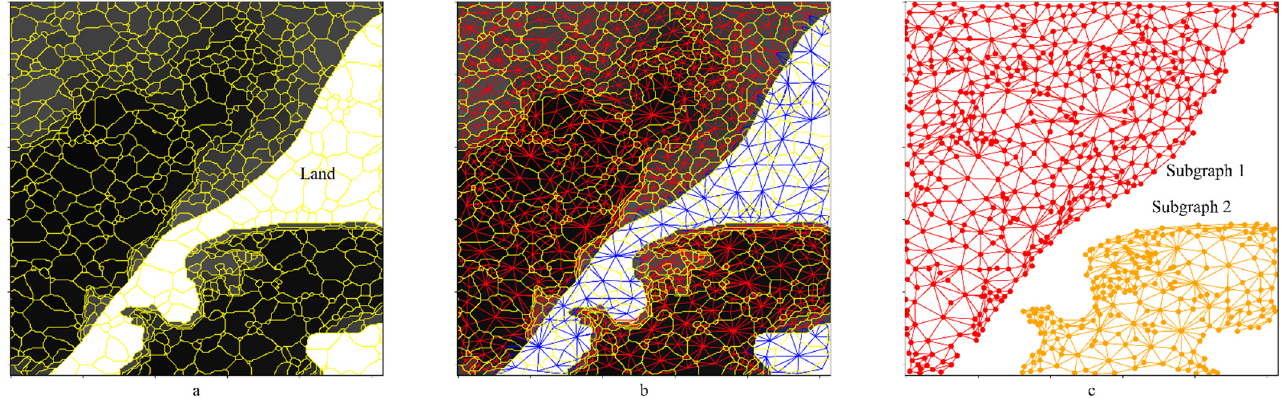
Figure 3. Conversion of the image to non-Euclidean structure data. ( a ) depicts superpixel segmen- tation in a SAR image, ( b ) describes the transformation of SAR images into graph structures with superpixels as nodes, and ( c ) depicts the removal of land nodes and the edges that connect to them.